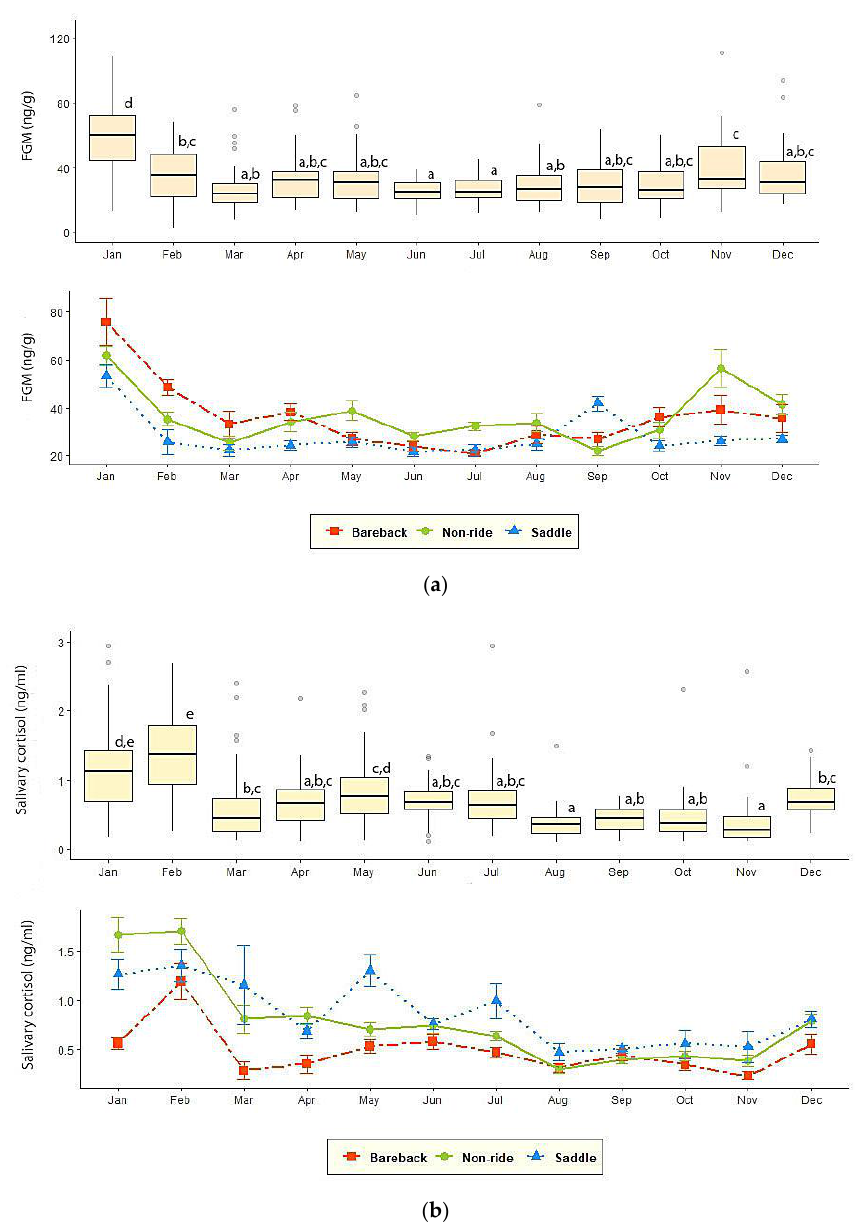
Figure 1. Mean (± SEM) monthly ( a ) fecal glucocorticoid metabolite (FGM) and ( b ) salivary cortisol concentrations in elephants involved in saddle-riding, bareback-riding, or no-riding. Box plots illustrate salivary cortisol and FGM measures for all elephants combined (N = 44). Whiskers represent median, quartiles, and the 25th/75th percentiles, error bars represent the 10th/90th percentiles, and open circles indicate outliers. Different superscripts indicate a significant difference at p < 0.05. For salivary cortisol, results often contrasted with FGM. For example, Camps A and F had the highest, while Camp D had the lowest measures. Elephants that participated in a bareback-riding program (0.49 ± 0.05 ng/mL) exhibited lower salivary cortisol concentrations than those in saddle- (0.86 ± 0.04 ng/mL) and no-riding (0.78 ± 0.03 ng/mL) groups, with the latter two being the same ( p =